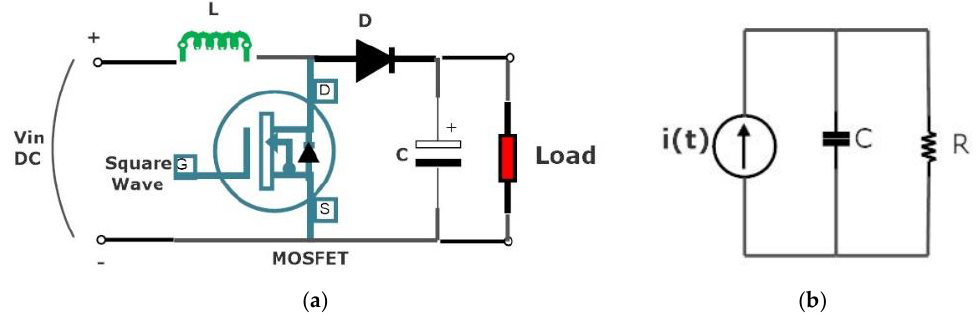
Figure 4. Squib energizing circuit. ( a ) Booster circuit for high current; ( b ) capacitor discharging circuit.